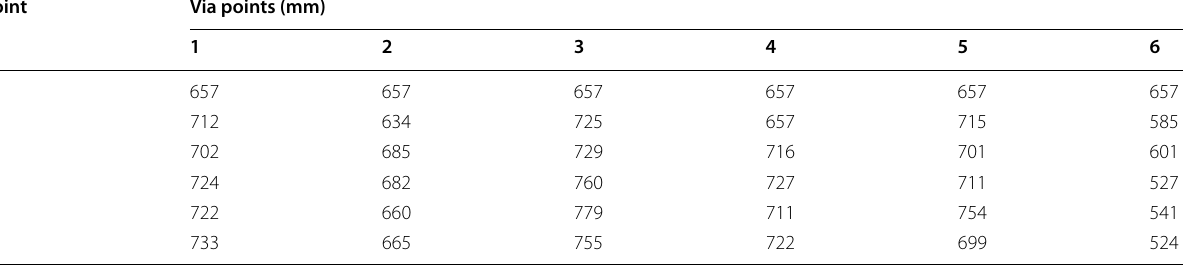
Table 2 Via points in joint space